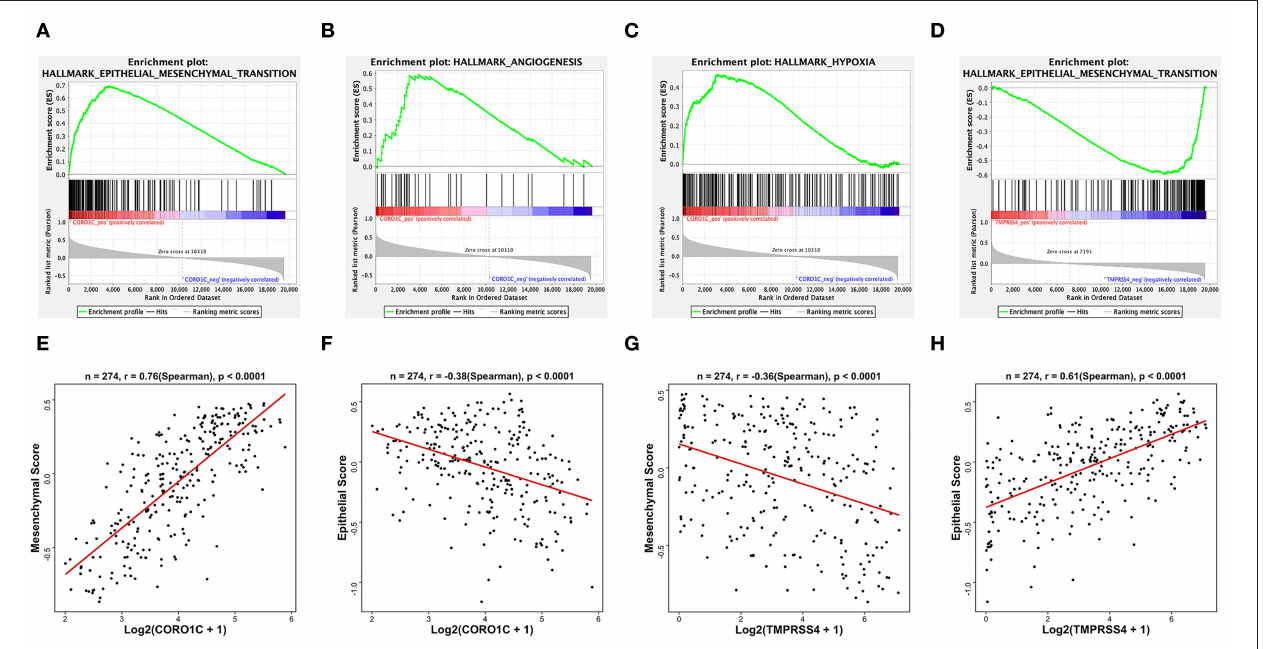
FIGURE 6 | Hallmark GSEA and EMT GSVA of hub genes based on TCGA-BLCA mRNA data. Some representative top enriched pathways of CORO1C were (A) epithelial to mesenchymal transition pathway, (B) angiogenesis pathway, and (C) hypoxia pathway. Only one downregulated GSEA result of TMPRSS4 enriched in (D) mesenchymal transition pathway. (E) GSVA pathway score of mesenchymal state gene set and (F) epithelial state gene set vs. normalized Log2(FPKM + 1) expression of CORO1C. (G) GSVA pathway score of mesenchymal state gene set and (H) epithelial state gene set vs. normalized Log2(FPKM + 1) expression of